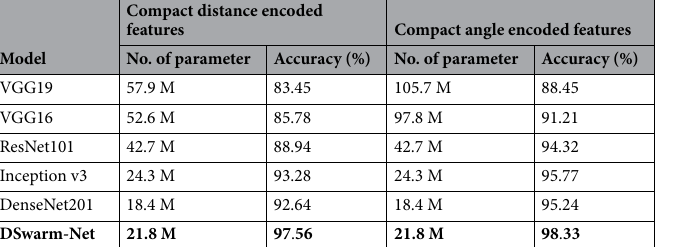
Compact distance encoded features Compact angle encoded Model